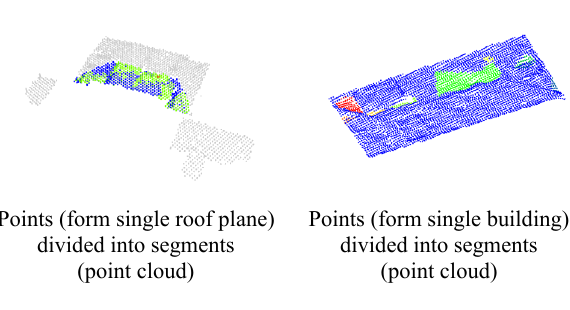
Figure 2. Example results of the following steps from the proposed method for both types of model (a) solid model and (b) the 3D mesh. From top to bottom: model, reference point cloud, roof planes (only for solid model), distances between points and model, point cloud with applied threshold, segments.